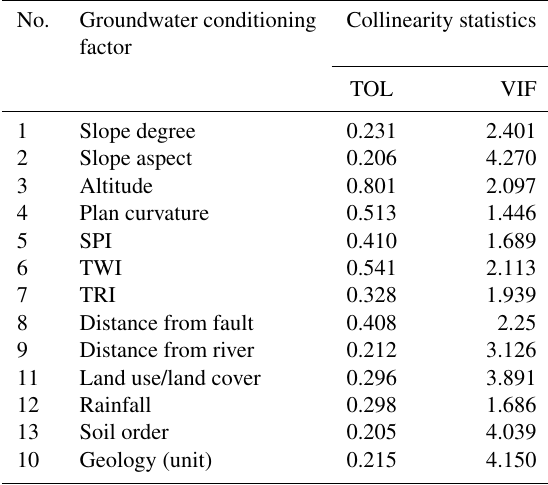
Table 1. Multicollinearity analysis of conditioning